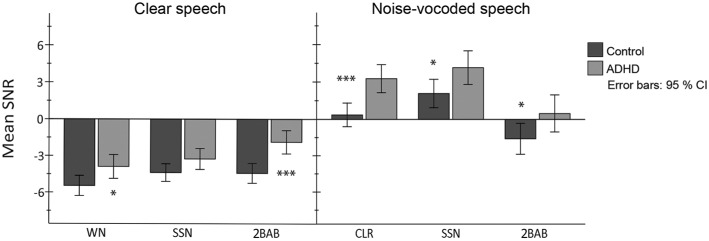
Results of between- and within-group comparisons per noise condition (WN: white noise; SSN: fluctuating speech-shaped noise; 2BAB: two-talker babble) and signal-quality manipulation (clear vs. noise-vocoded speech). Positive and negative estimated marginal means of SNRs resemble a reduction (<70 dB) and increase (>70 dB) in noise levels, respectively (the speech-signal was held at a constant of 70 dB). Asterisks indicate significant between-group differences for each masker type per signal-quality condition (*p < 0.05, ***p < 0.001, Bonferroni corrected).